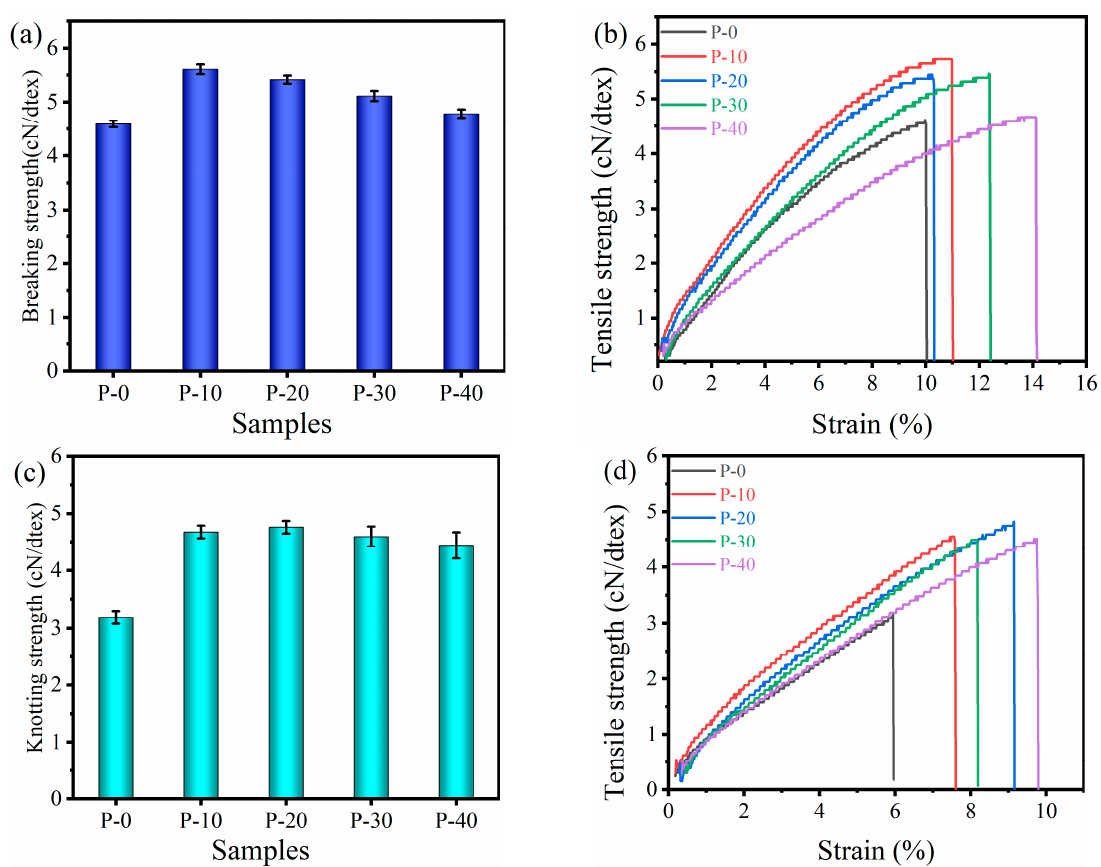
Figure 4. Mechanical property of the PP − g − PHMG/PP − blended monofilaments: ( a ) breaking strength, ( c ) knotting strength, and their tensile curves ( b ) and ( d ), respectively.